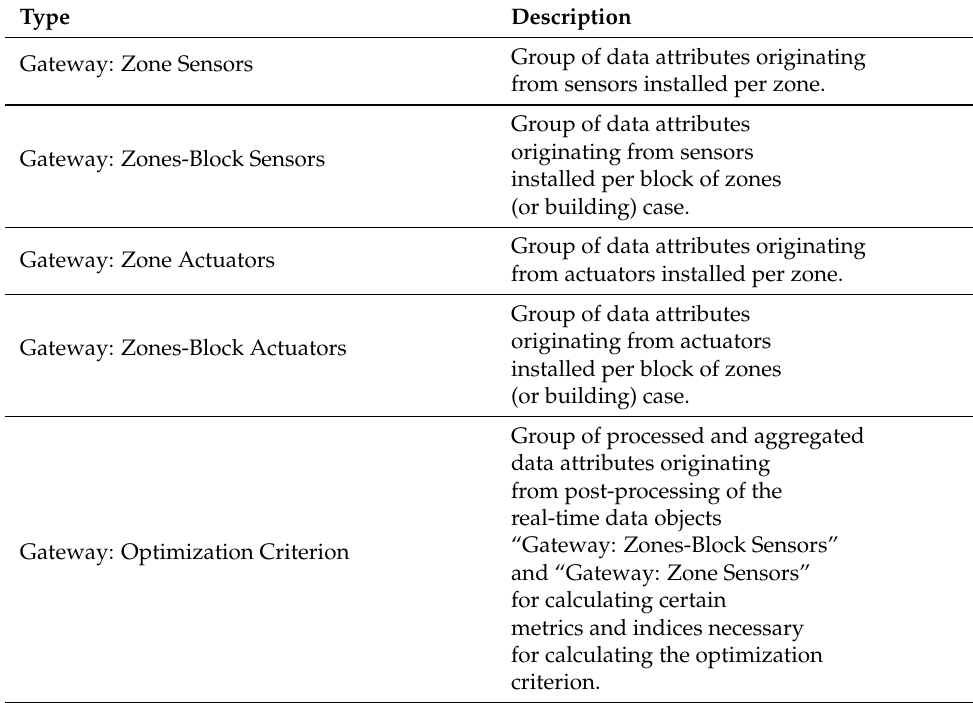
Table 2. Common Data Object